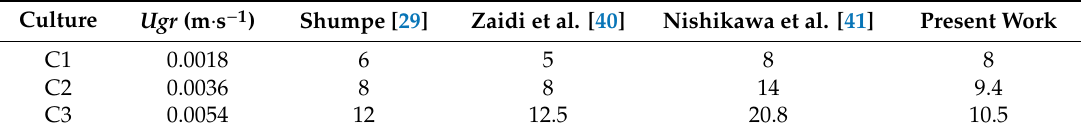
Table 5. Comparison of global shear rates γ in [1 / s] from other authors respect the values we obtained in cultures C1, C2, and C3 as a function of Ugr .